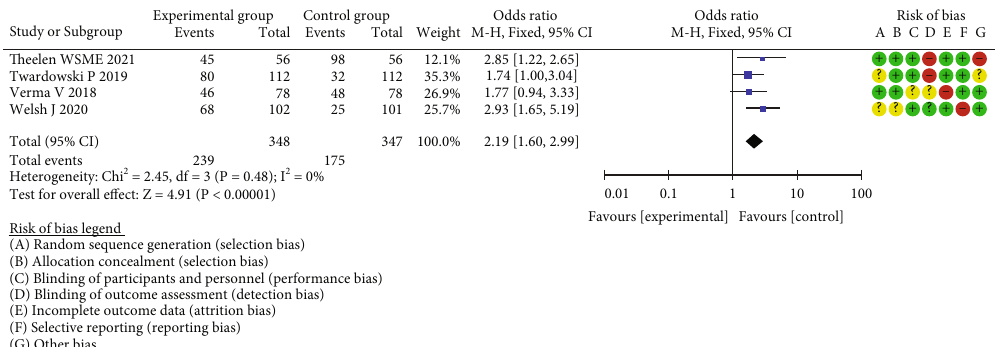
3.6. Published Bias Analysis. Use RevMan5. 0. The inverted